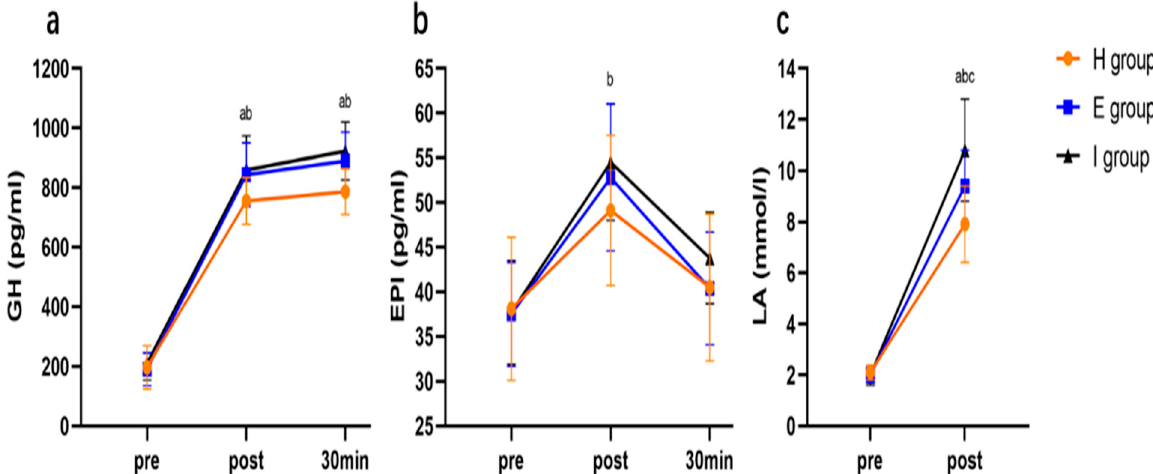
Figure 5. Changes in GH ( a ) , EPI ( b ), and LA ( c ) after exercise. Note: a statistical difference in E group compared with H group; b statistical difference in I group compared with H group; c statistical difference in I group compared with E group. GH = growth hormone; EPI = epinephrine; LA = lactic acid.